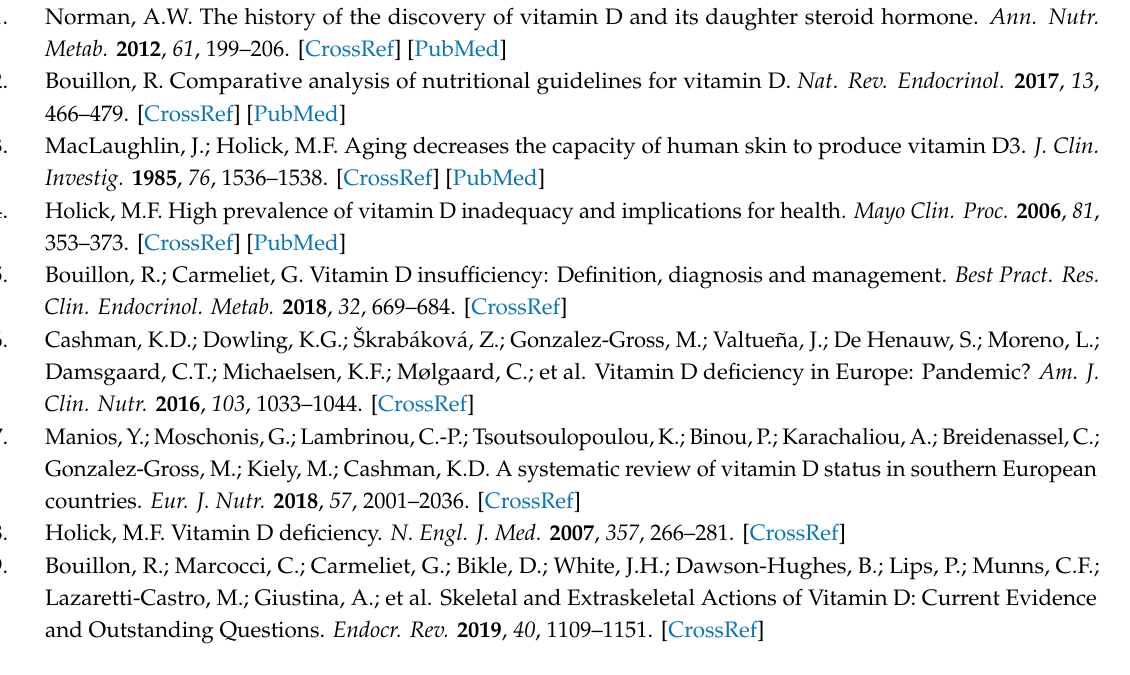
Table S1: statistical analysis of pharmacokinetic parameters for 25(OH)D3 following repeated oral doses of cholecalciferol, Table S2: subjects with 25(OH)D levels ≥ 20 ng / mL and ≥ 30 ng / mL on Day 7, 14, 21, 28, 35, 42, 49, 56, 63, 77, 84, 85, 87, 89, 96, 103, 112, Table S3: pharmacodynamic parameters over time, Table S4: summary of adverse events during the